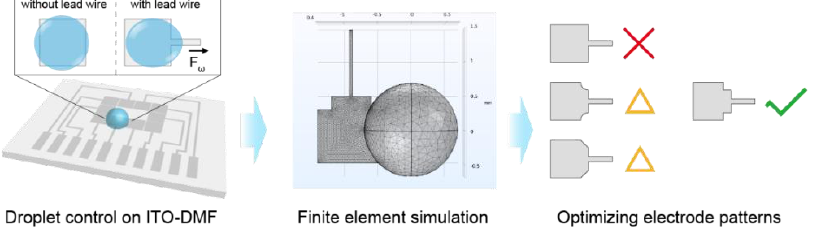
Figure 1. The force induced by the lead wire of electrodes on ITO-DMF causes deformation of the droplets and affects the droplet movement. A finite element model is developed for the optimization of the electrode pattern to enhance the stability of droplet control on ITO-DMF.